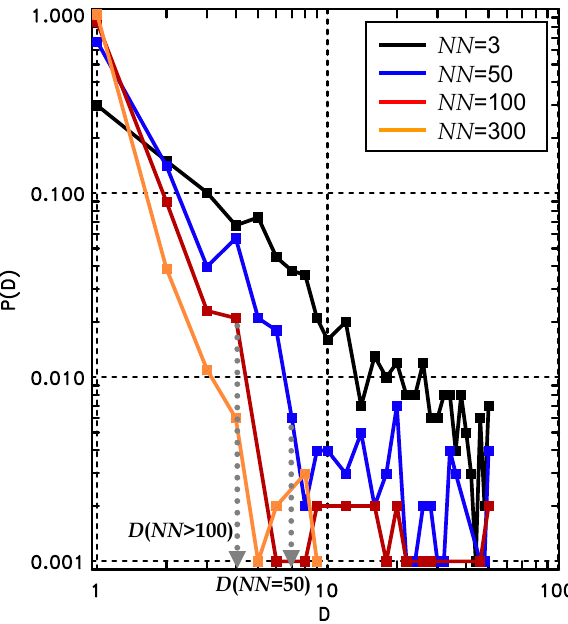
Fig. 6. Distribution functions of D n calculated with ε = 0 . 5 and different values of NN for the time series generated by the synchro- nized Lorenz attractor with 1/ f -noise contamination ( σ 1 /f ). For different NN the distribution function drops to zero at different val- ues of D . The mean-field dimension decrease with the increase in the range of scale smoothed away after the